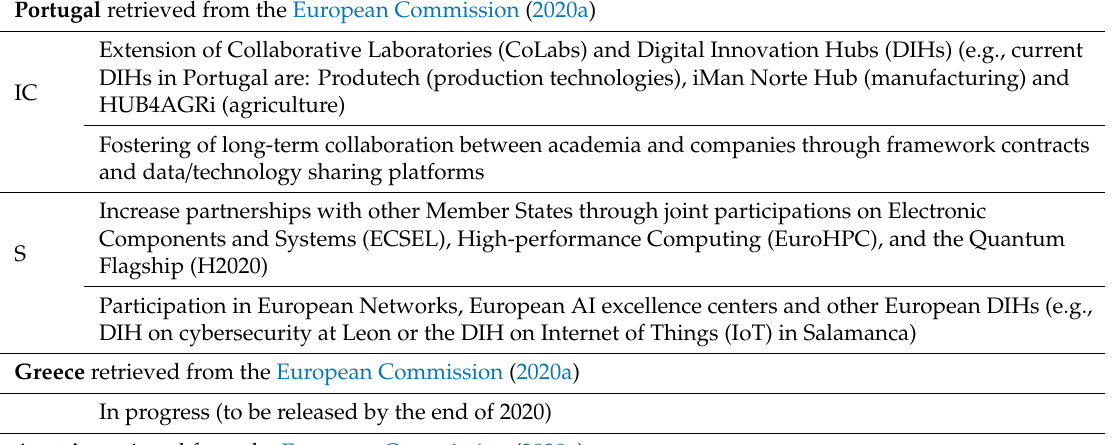
Table 1. Declared networking